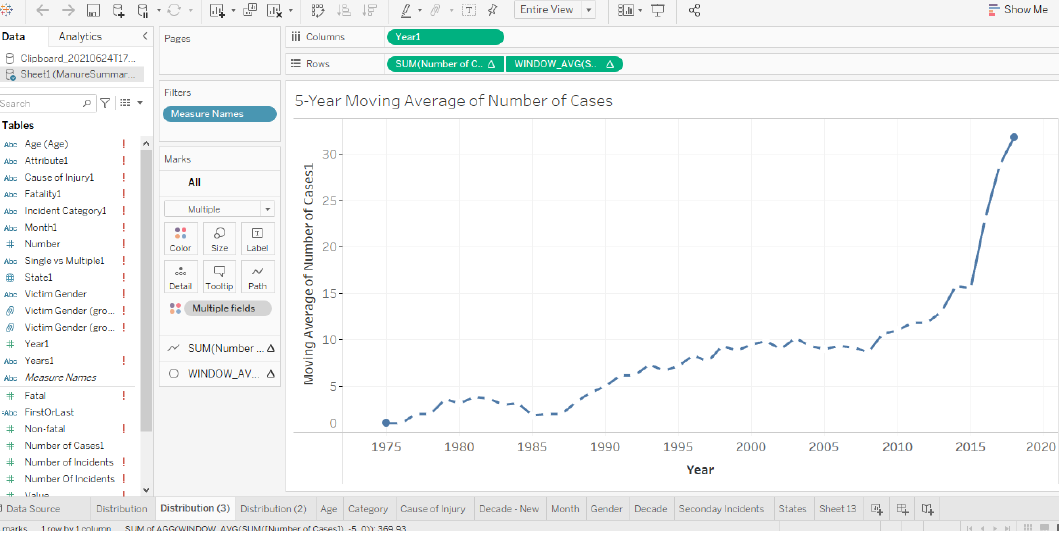
Figure 11. Dashboard software display of agricultural waste injury and fatality data, 1975 –